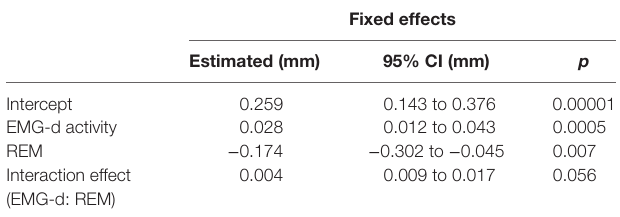
The table represents the fixed effects of EMG-d activity, REM sleep stage (as binary factor), and interaction between them in a random slope model.